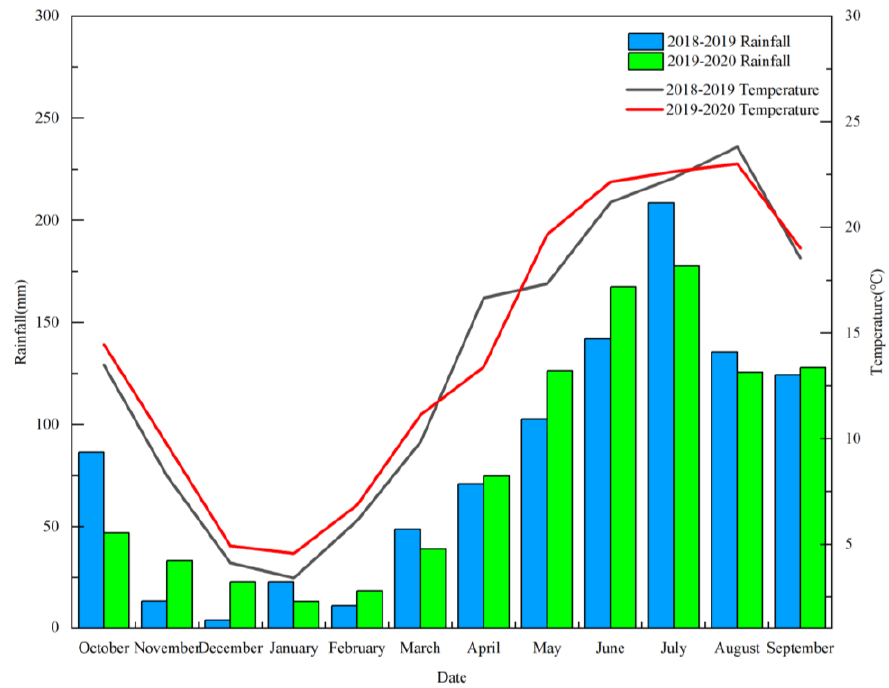
Figure 1. Meteorological data of rainfall and temperature during the experiment.